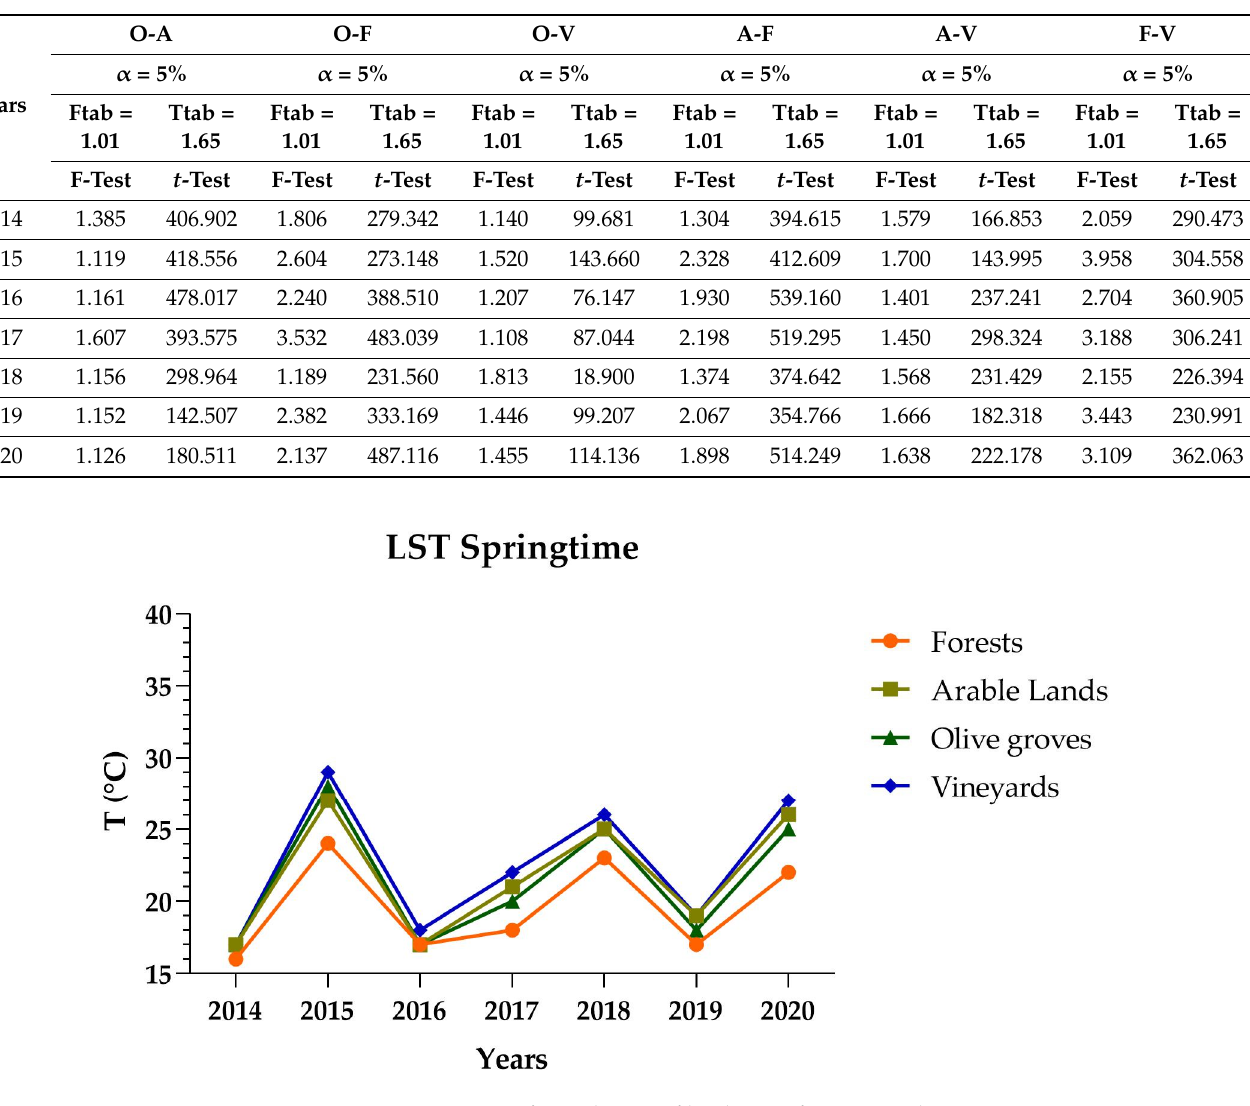
Table 2. Fisher test and Student test to analyse the statistical differences among the land covers reported in the Figure 4.